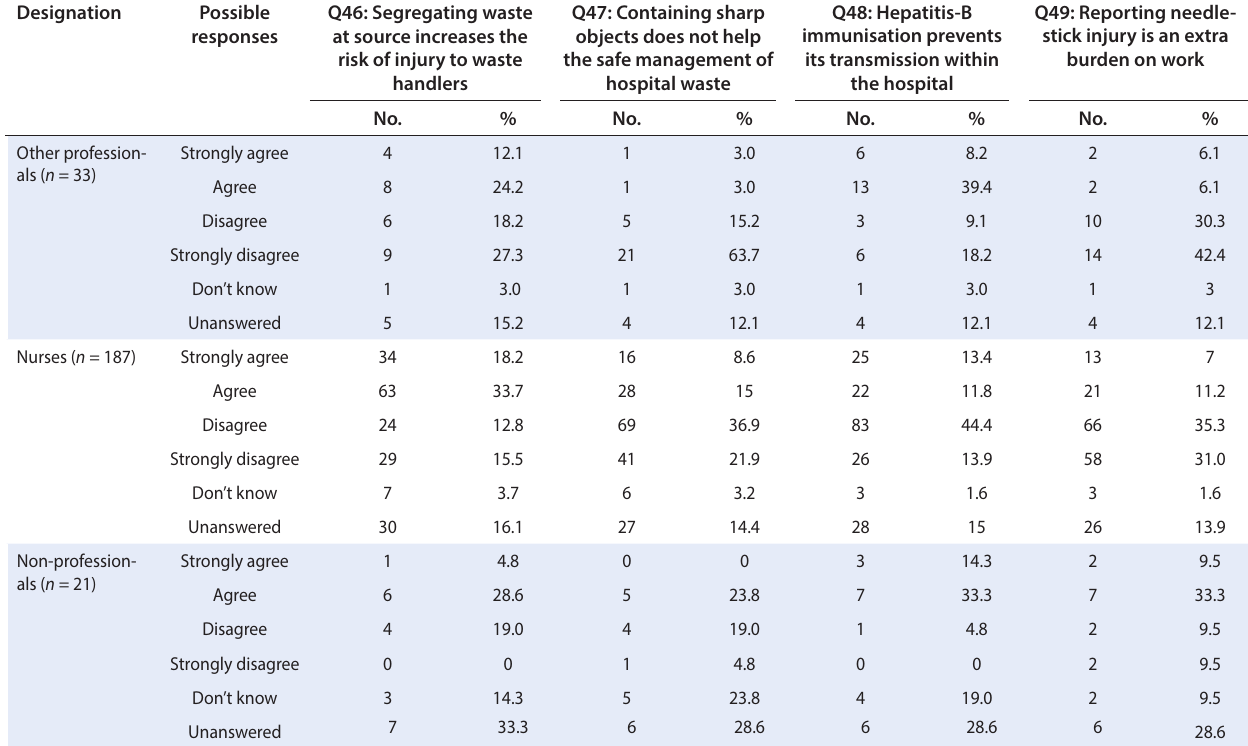
Table 4: Overall attitude of healthcare workers about healthcare waste Designation